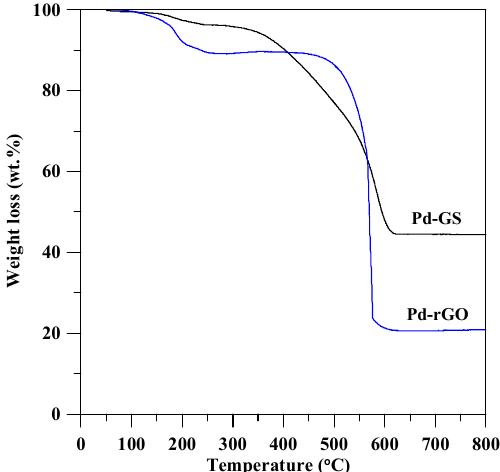
Figure 2. Thermo-gravimetric analyzer (TGA) weight loss curves of different catalyst electrodes.